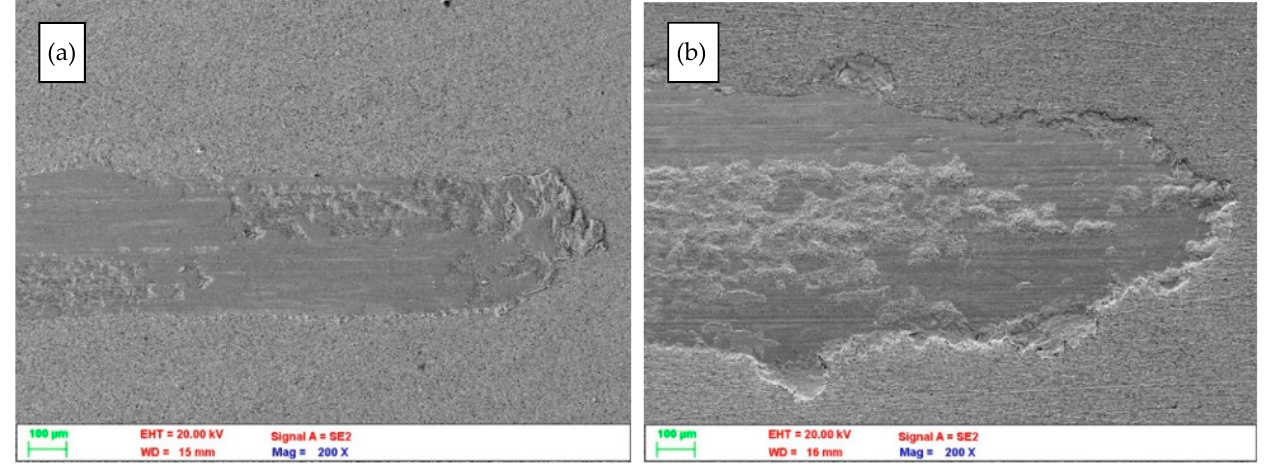
Figure 5. SEM images of the scratch trace of the surface of the CuNi2Si alloy made with an Al 2 O 3 indenter, solution heat treated and aged at 650 °C for ( a ) 1 and ( b ) 7 h.